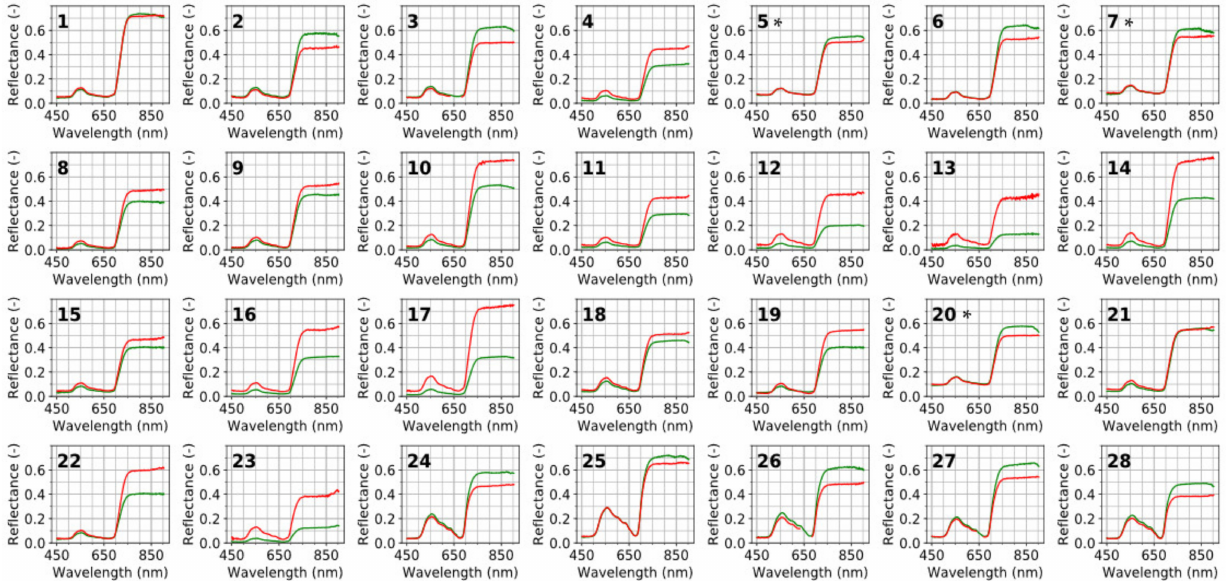
Figure 6. Comparison of leaf reflectance computed with at-target and horizontal white reference panels. Green spectral curves correspond to those obtained with the horizontal white reference (HW), while the red signatures to those obtained with the at-target white references (TW). (*) Indicates samples with all pixels affected by the specular